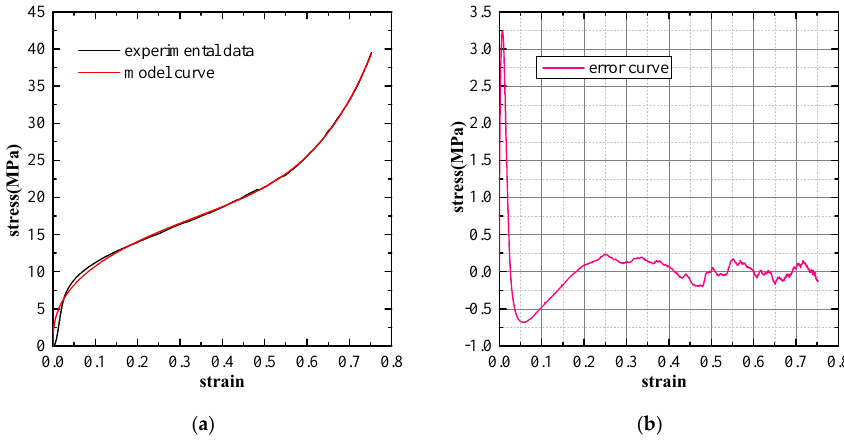
Figure 8. ( a ) Comparison between the curve predicted by the Rusch model and the experimental curve ( ρ ∗ / ρ s = 0.326); and ( b ) model prediction